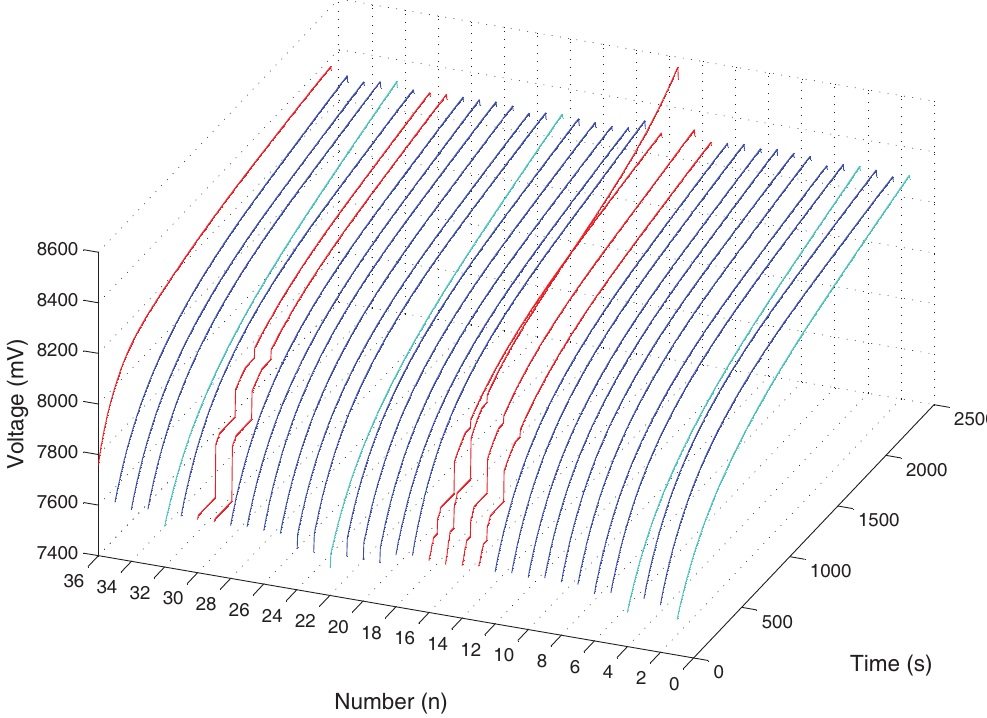
Figure 16. The voltage characteristic of monomer after two years of operation without range